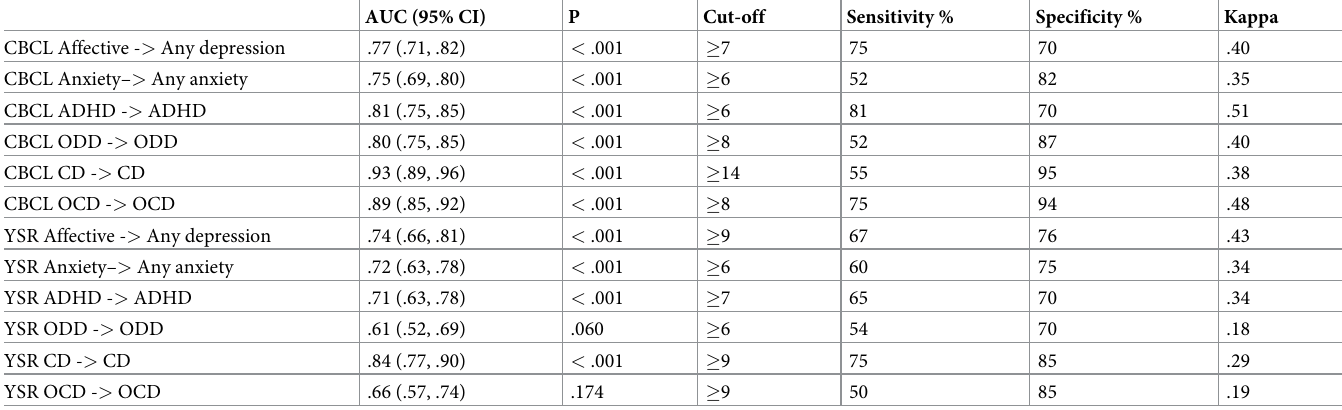
Table 3. Psychometric properties for the CBCL and YSR versus a LEAD diagnosis.